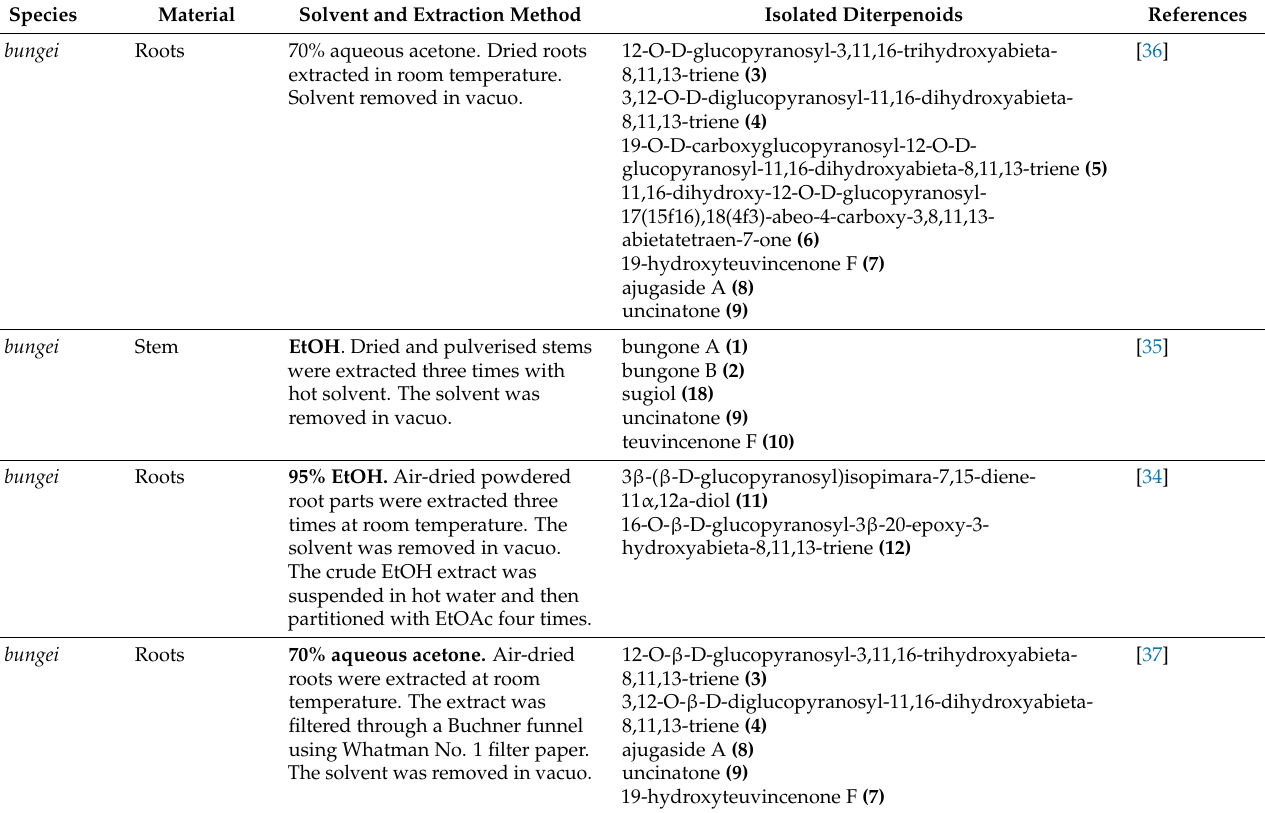
Table 1. The diterpenoid extraction methods and C. bungei plant material for diterpenoid isolation. Species Material Solvent and Extraction Method Isolated